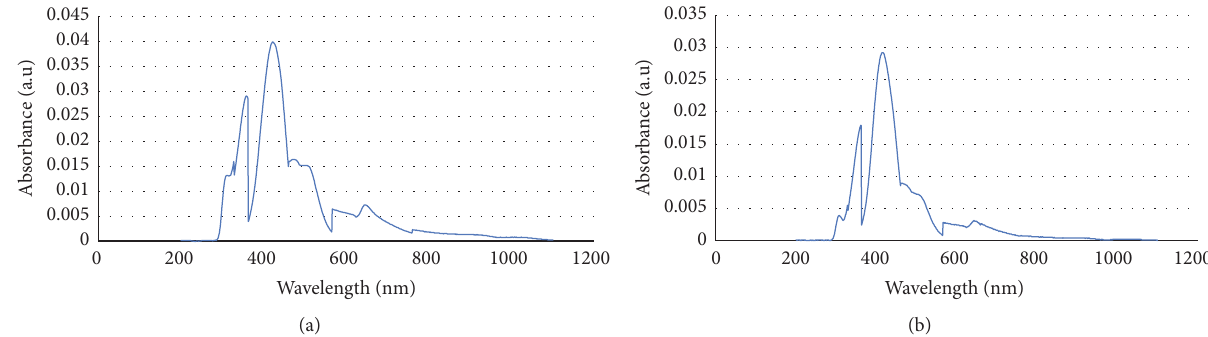
Figure 11: UV-VIS absorption spectra of silver nanoparticles solution prepared by 200 pulses with laser energy of (a) 700mJ and (b) 760 mJ.